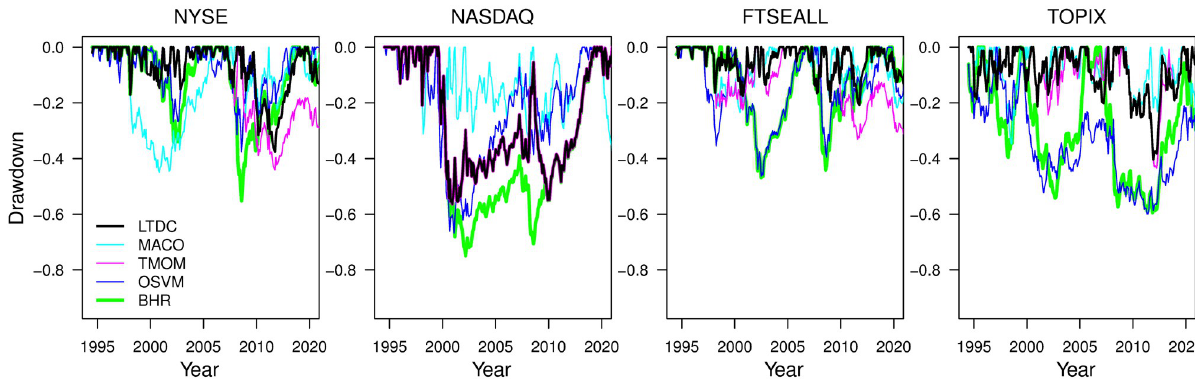
Fig 7. Time series plot of the drawdown at the d